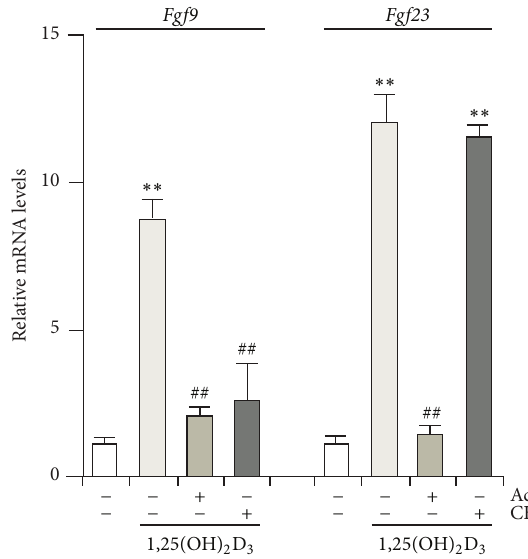
Figure 3: 1,25(OH) 2 D 3 increases Fgf9 and Fgf23 gene expression at late development stages in rat calvaria cell cultures. Rat calvaria cells were obtained as shown in Figure 2. At day 11, nodule-forming cells were stripped by collagenase and replated (subcultures). Four days later, osteoblast subcultures were pretreated with or without actinomycin D (ActD) or cycloheximide (CHX), followed by incu- bation with 1nM 1,25(OH) 2 D 3 for 6h. See the above mentioned for qPCR. Data represent means ± S.D. 𝑛 = 3 . Statistical significance of differences was analyzed with one-way or two-way analysis of variance (ANOVA) with repeated measures, followed by Tukey’s multiple comparison test. ∗∗ 𝑃 < 0.01 versus vehicle alone; ## 𝑃 < 0.01 versus 1,25(OH) 2 D 3 alone.